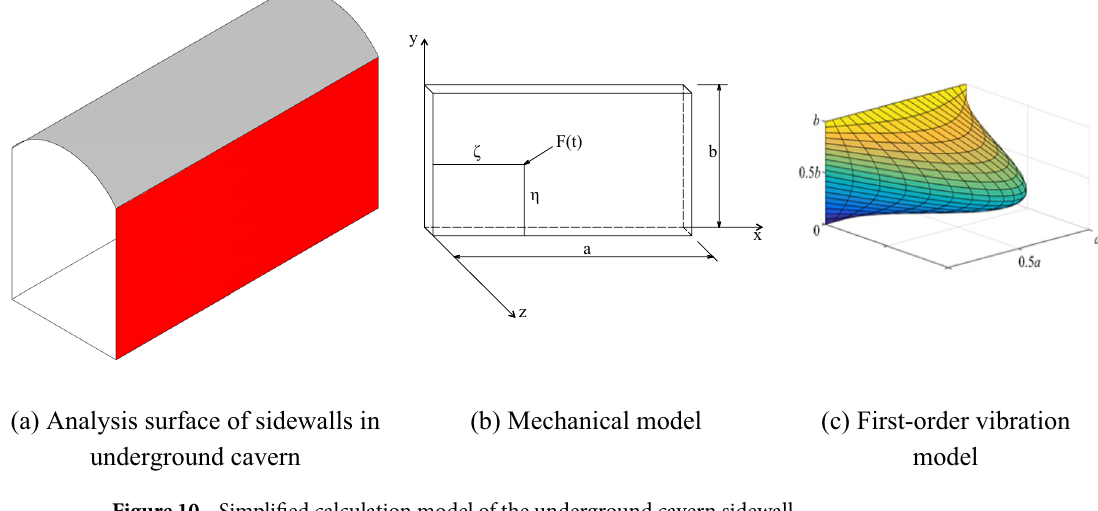
Figure 10. Simplified calculation model of the underground cavern